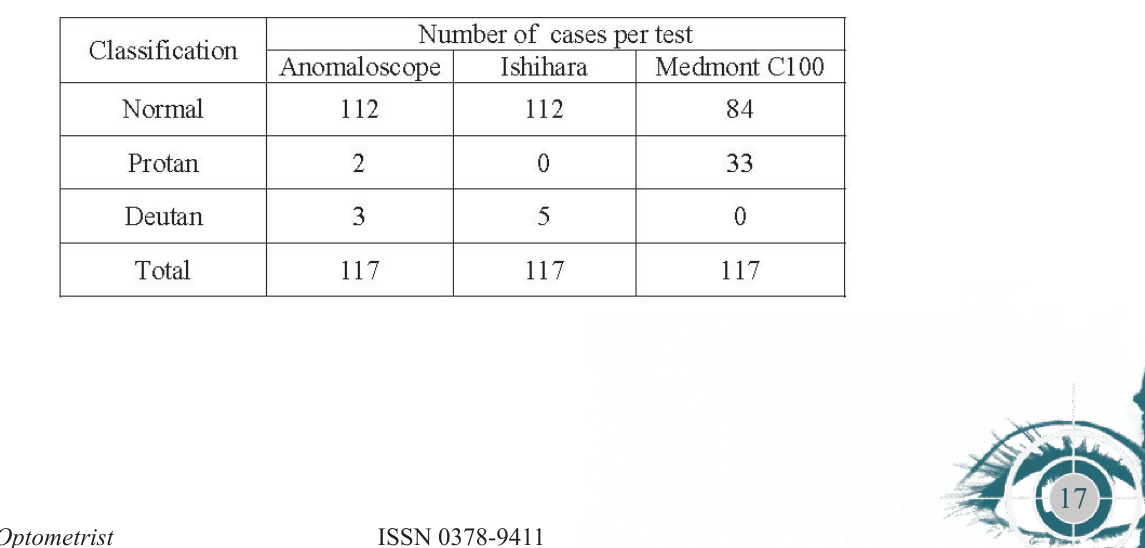
Table 1. Comparison of the classification and number of cases as obtained with the three colour vision